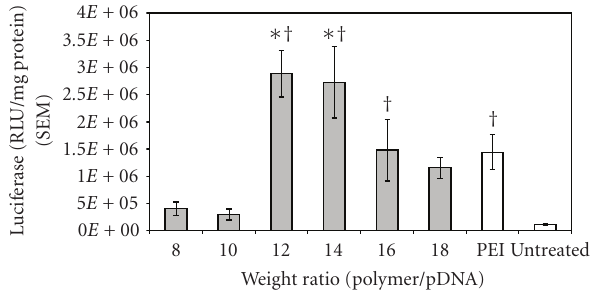
Figure 1: Transfection e ffi ciency of D-SPM/pCIKLux complex at various weight-mixing ratios with 0.5 μ g pCIKLux in COS-7 cells. PEI was used as the positive control. Luciferase expression was measured as RLU/mg protein after 48h posttransfection in serum- free condition. Luciferase expressions significantly higher than PEI are denoted by asterisks ( ∗ ) ( P < . 05) while from untreated are denoted by dagger ( † ) ( P < . 05). Data are presented as mean ± S. E. M of experiments conducted in triplicate.